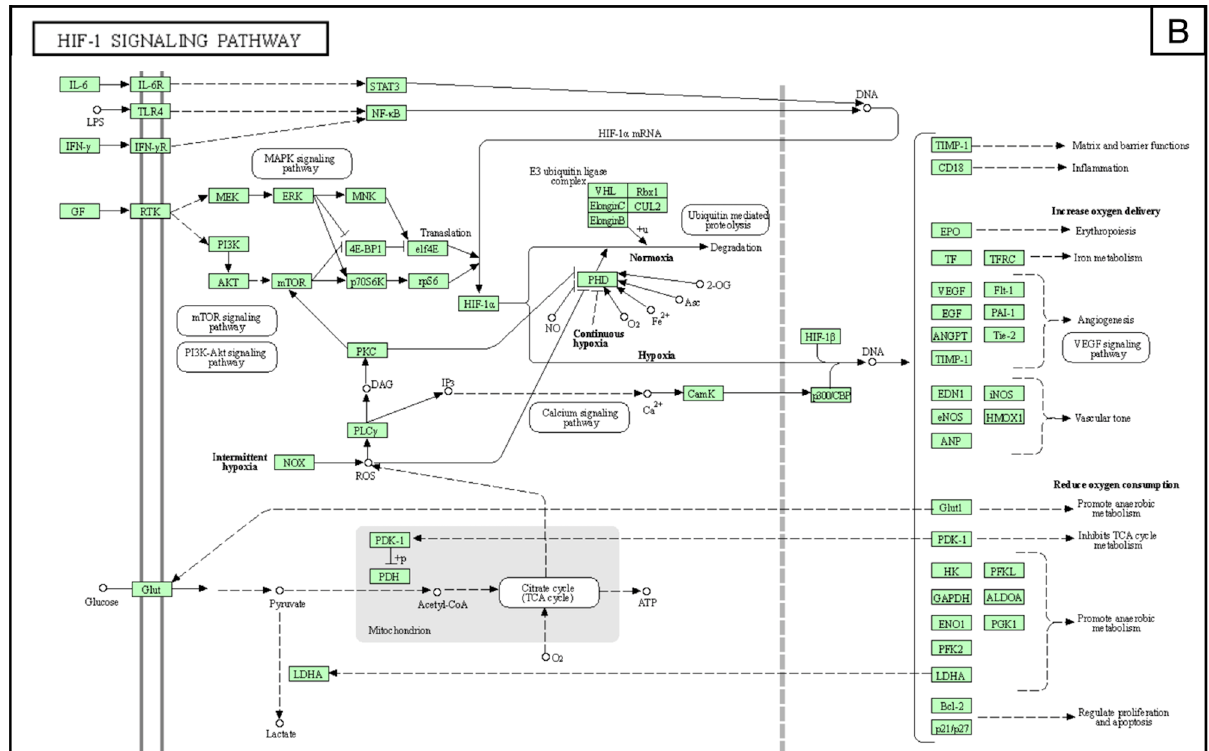
Figure 8. ( A ) VEGF regulated genes and signaling pathways. The vascular endothelial growth factor (VEGF) pathway activates several signaling pathways, which results in the upregulation of genes involved in the survival, proliferation, and migration of endothelial cells and vascular permeability. The binding of VEGF to VEGFR-2 leads to dimerization of the receptor, followed by intracellular activation of the VRAP and PLC γ , linked to the calcium signaling pathway; phosphoinositide 3-kinase (PI3K)/protein kinase D1(PDK1)/protein kinase B (Akt); and rapidly accelerated fibrosarcoma kinases (Raf)/mitogen-activated protein kinase (MAP kinase)/extracellular signal-regulated kinase (ERK) involved in DNA synthesis and cell growth. Activation of PI3K, FAK, and p38 MAPK is implicated in cell migration signaling. ( B ) HIF-1 α regulated genes and signaling pathways. Hypoxia- inducible factor 1 (HIF-1) is the master intracellular regulator of oxygen homeostasis. It consists of two subunits: the inducibly-expressed HIF-1 α and the constitutively expressed HIF-1 β subunit. Under hypoxia, the HIF-1 α interacts with coactivators, such as p300/CBP, to modulate the transcription of multiple hypoxia-inducible genes. Among the target genes are the vascular endothelial growth factor (VEGF), epidermal growth factor (EGF), erythropoietin (EPO), endothelial nitric oxide synthase (eNOS), glucose transporter (GLUT), and glyceraldehyde-3-phosphate dehydrogenase (GAPDH), inducing angiogenesis in response to reduced oxygen availability, cell proliferation, vascular tone, erythropoiesis, iron, and anaerobic metabolism,